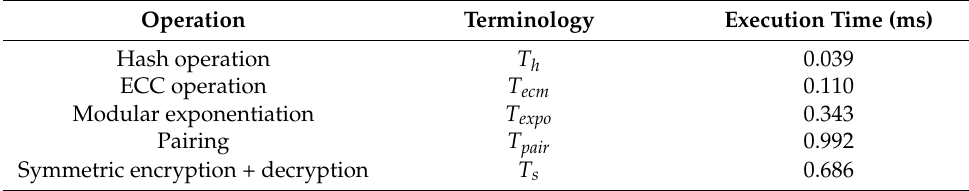
Table 3. Primitive timing for cryptography